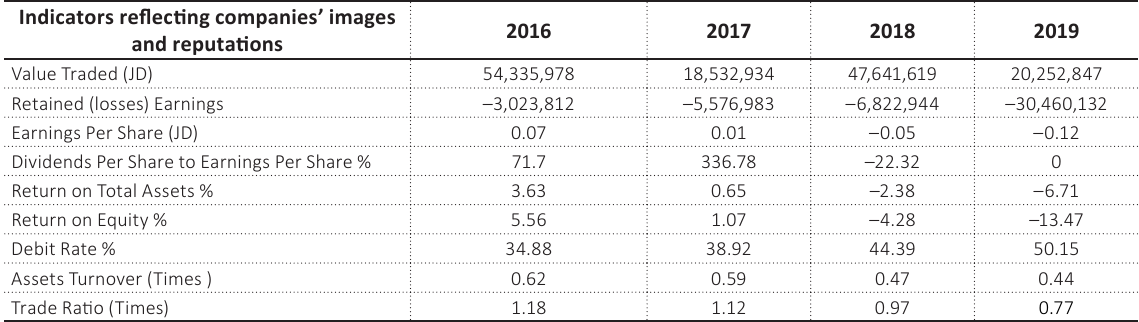
Source: Amman Stock Exchange